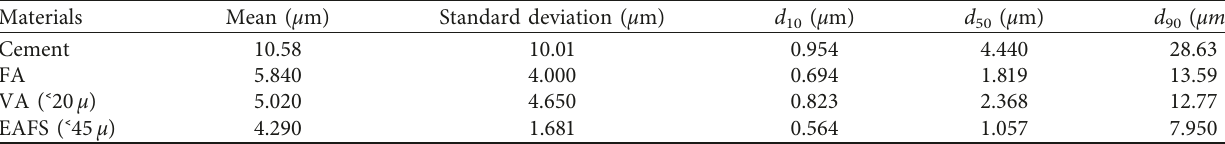
Table 4: Particle size distribution of cement and SCMs.